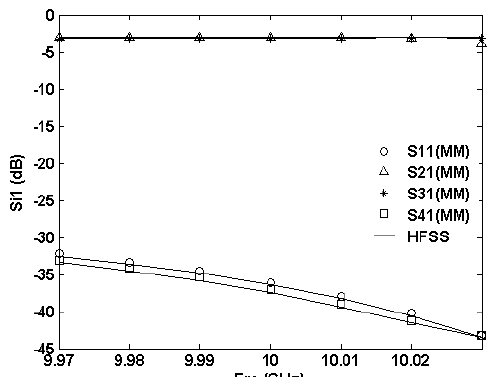
Figure 2. Magnitude of the scattering coefficients directional coupler.